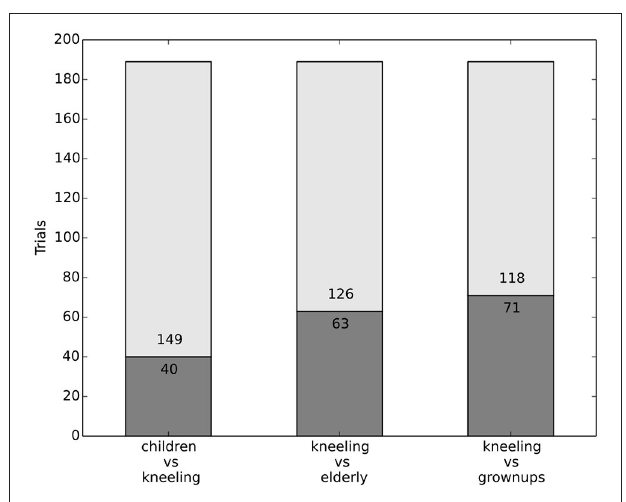
FIGURE 4 | Relative risk of injury seems to play a